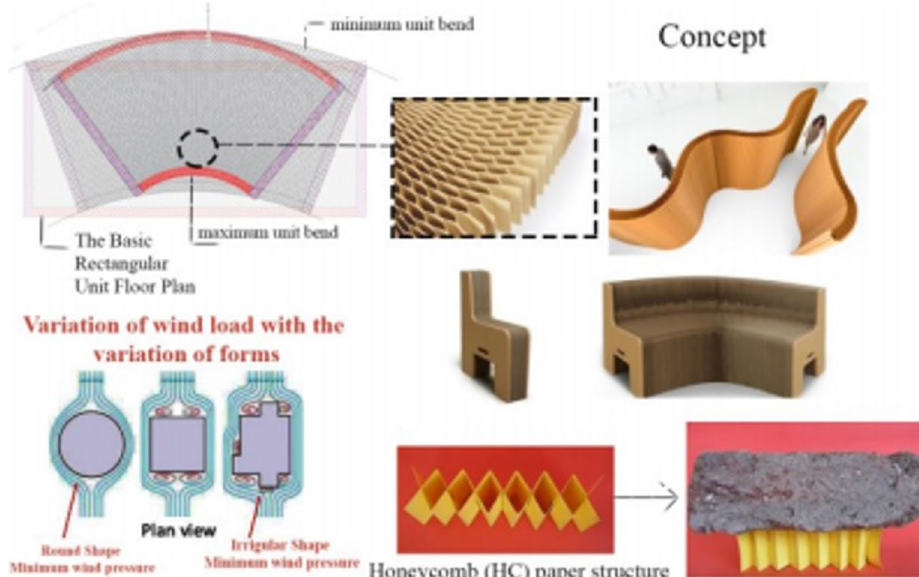
Fig. 10 Concept study summary for the shelter